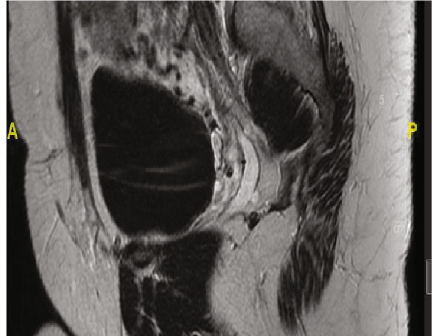
Figure 4: MRI imaging with radiology report eccentric intrauterine pregnancy associated with the c-section scar, extending into the posterior-lateral left adnexa where the placenta is uncovered from the myometrium. The placenta abuts the bladder without evidence for direct